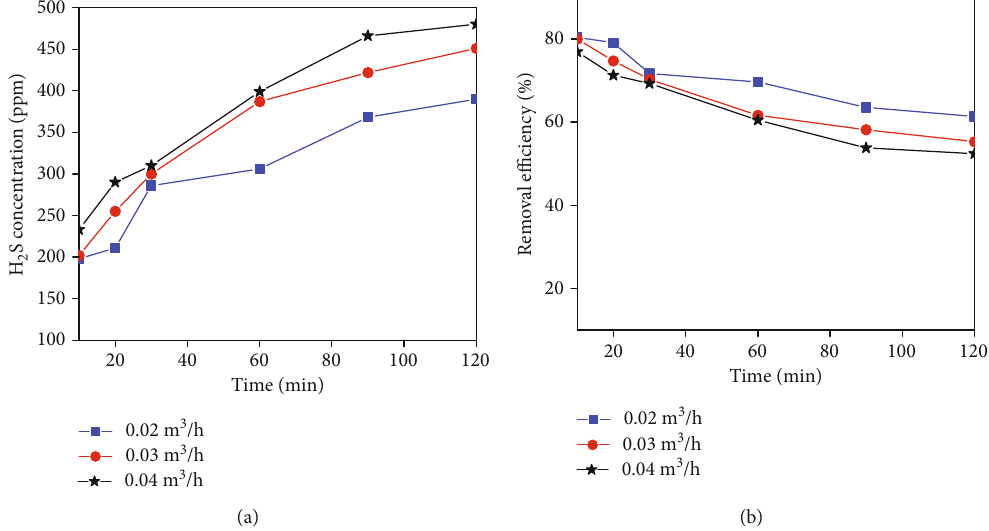
Figure 7: E ff ect of biogas fl ow rate on the samples ’ adsorption performance: (a) H conditions: T = 800 ° C , m = 0 : 3 g , KOH:C 1 :1, C c